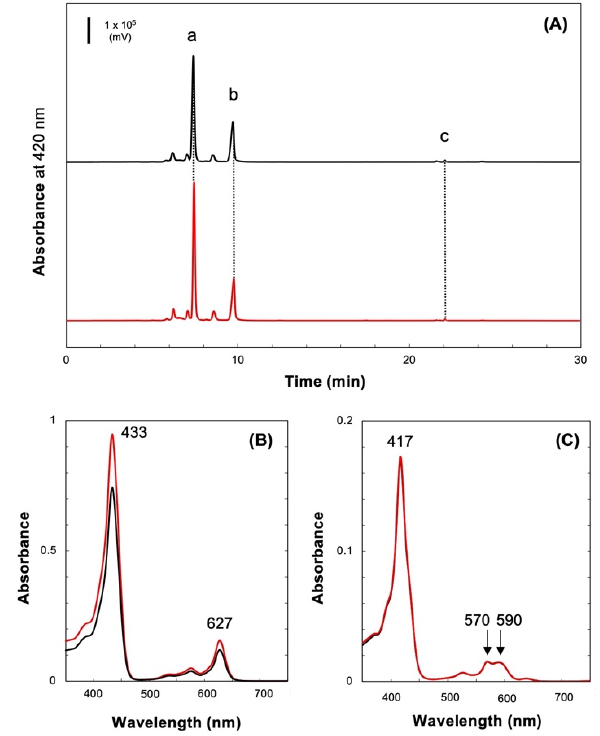
Figure 3. Pigment analysis of dark-grown YFC2. ( A ) HPLC profiles of pigments (90% methanol) extracted from the culture medium (black traces) and the ultracentrifugation fraction (Fraction 0, red traces). Peaks a, b, and c are monovinyl Pchlide, protopheophorbide, and Chl, respectively. ( B ) Absorption spectra of peak a of (A). ( C ) Absorption spectra of peak b of (A).